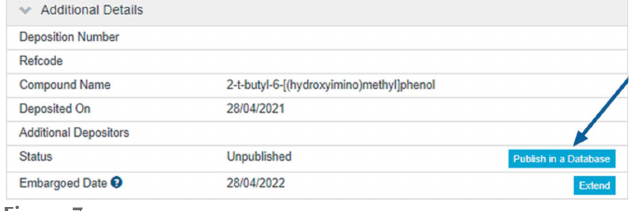
Figure 7 ‘Publish in a Database’ for previously deposited data in ‘My